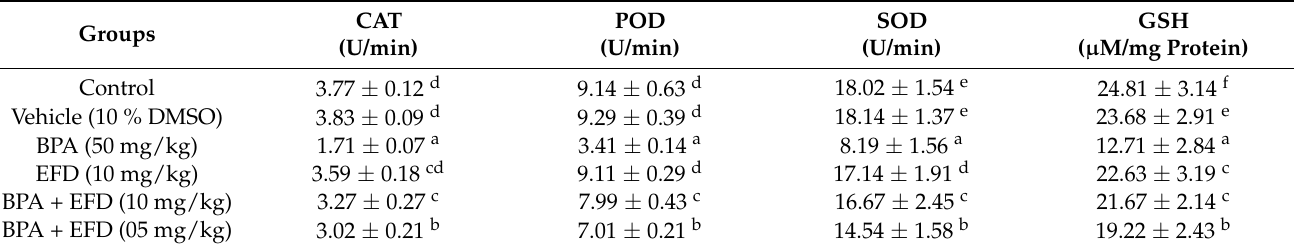
Table 5. Effect of EFD on biochemical levels.